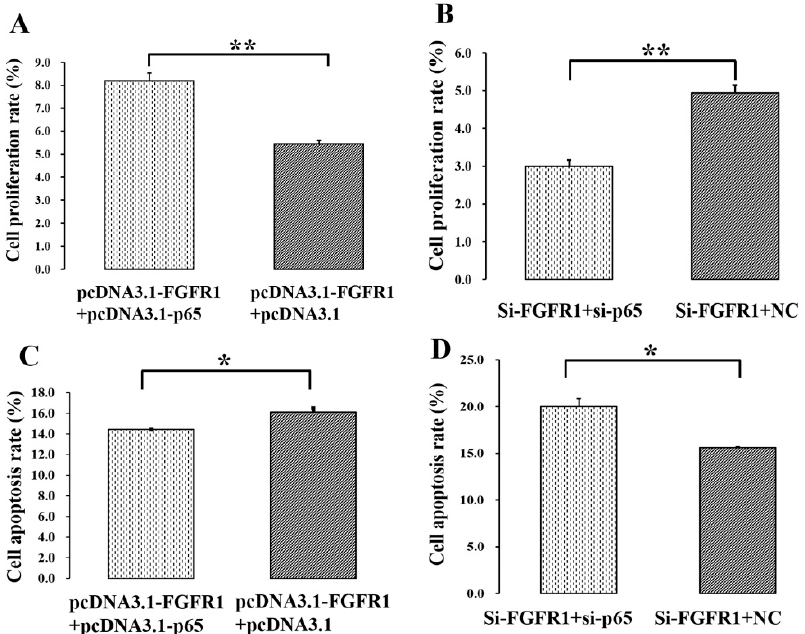
Figure 7. p65 enhances the pro-proliferation and anti-apoptotic effects of FGFR1 in GCs. ( A ) PcDNA3.1-p65 increased the cell proliferation rate of pcDNA3.1-FGFR1 in GCs; ( B ) si-p65 decreased the cell proliferation rate of si-FGFR1 in GCs; ( C ) pcDNA3.1-p65 depressed the cell apoptosis rate of pcDNA3.1-FGFR1 in GCs; ( D ) si-p65 stimulated the cell apoptosis rate of si-FGFR1 in GCs. Data are represented as means ± SD. NC: negative control; PcDNA3.1-FGFR1: pcDNA3.1 overexpression plasmid of FGFR1 ; PcDNA3.1-p65: pcDNA3.1 overexpression plasmid of p65 ; si-FGFR1: specific siRNA for FGFR1 ; si-p65: specific siRNA for p65 ; NC: negative control; * indicates p < 0.05; ** indicates p < 0.01.